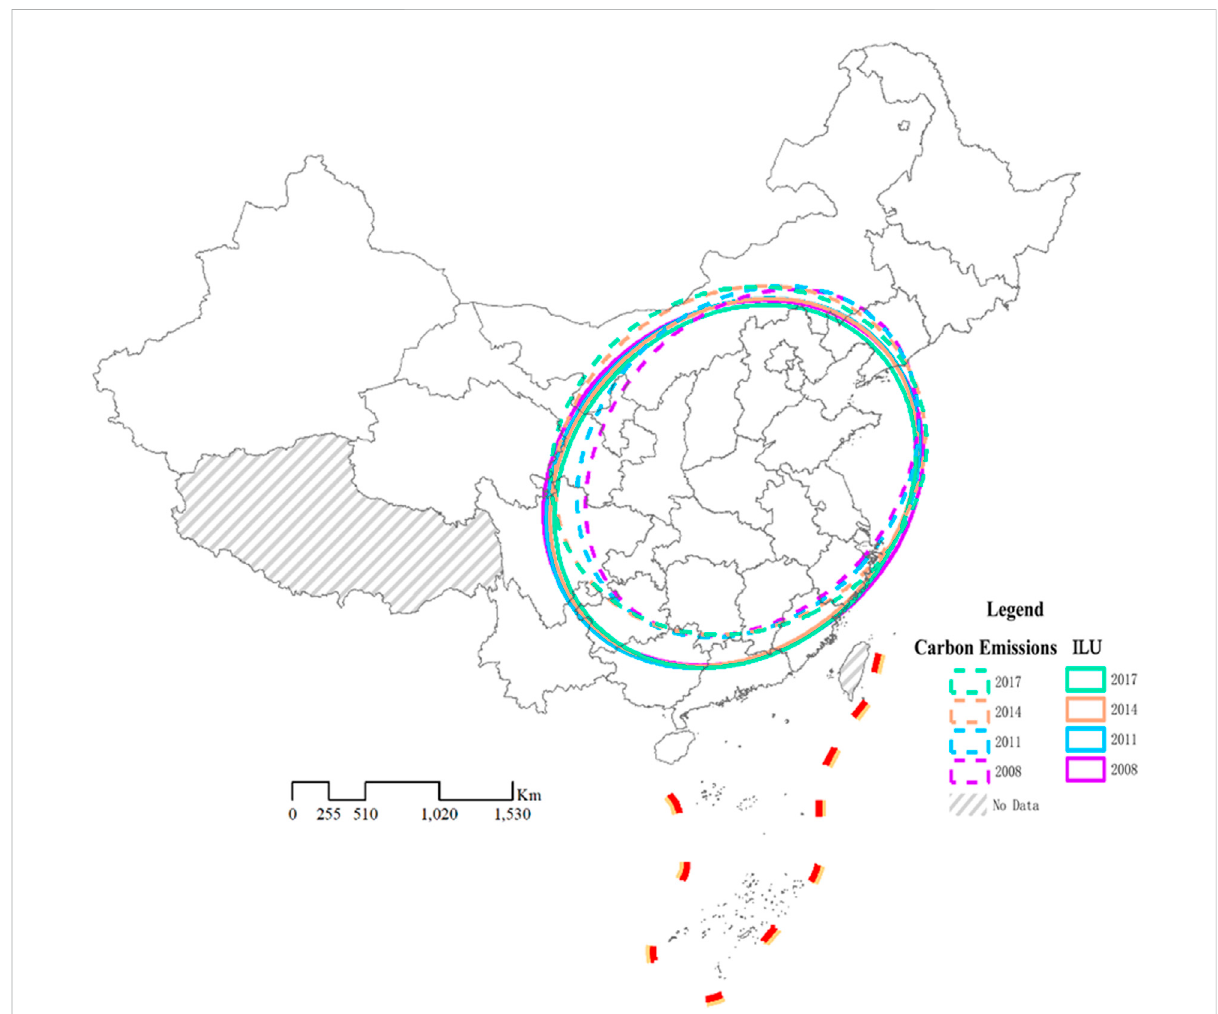
FIGURE 4 Elliptic distribution of the standard deviation of ILU and carbon